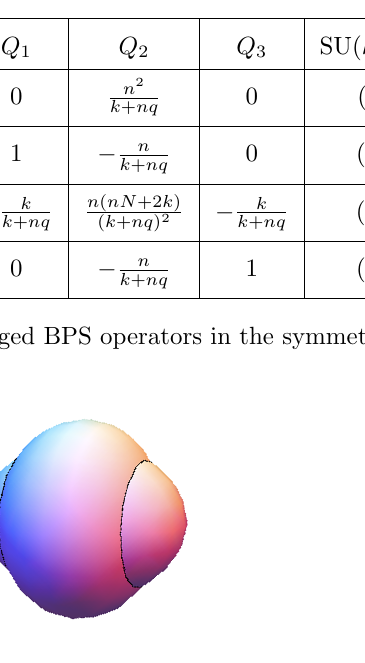
Figure 12 . A two-dimensional projection of the internal space M symmetric